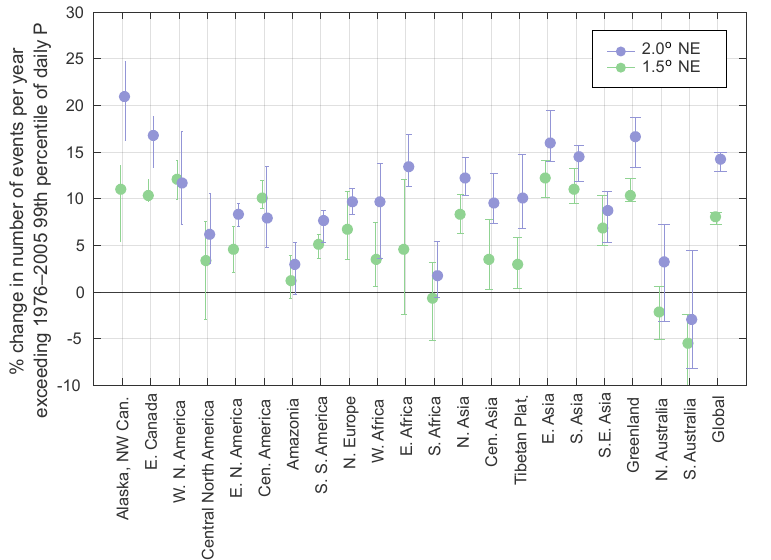
Figure 10. Aggregated percentage change in the aggregated frequency of exceedance of the historical 99th percentile of precipitation over regions as defined in Giorgi and Mearns (2002). Historical 99th percentile is calculated at a grid-cell level from the distribution daily precip- itation from years 1976–2005, for ensemble members 1–10 (making 300 years of data). Events exceeding their point-level 99th percentile are summed over the relevant region for each ensemble member, such that the ensemble mean value of the number of exceedances repre- sents the baseline. Future values are calculated from years 2071–2100 of 2.0degNE and 1.5degNE, again summing events which exceed the 1976–2005 99th percentile. The ensemble mean and range of percentage change in number of events in 2071–2100 relative to 1976–2005 is